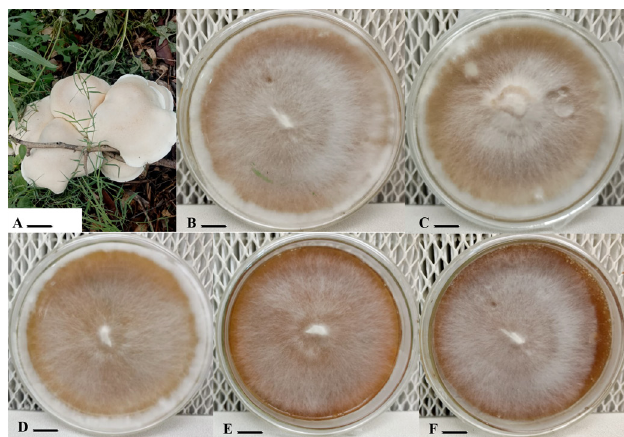
Table 1: Mycelial growth rate (mm/day) of M. gigantea on different media at different temperatures. CEA, Compost Extract Agar;